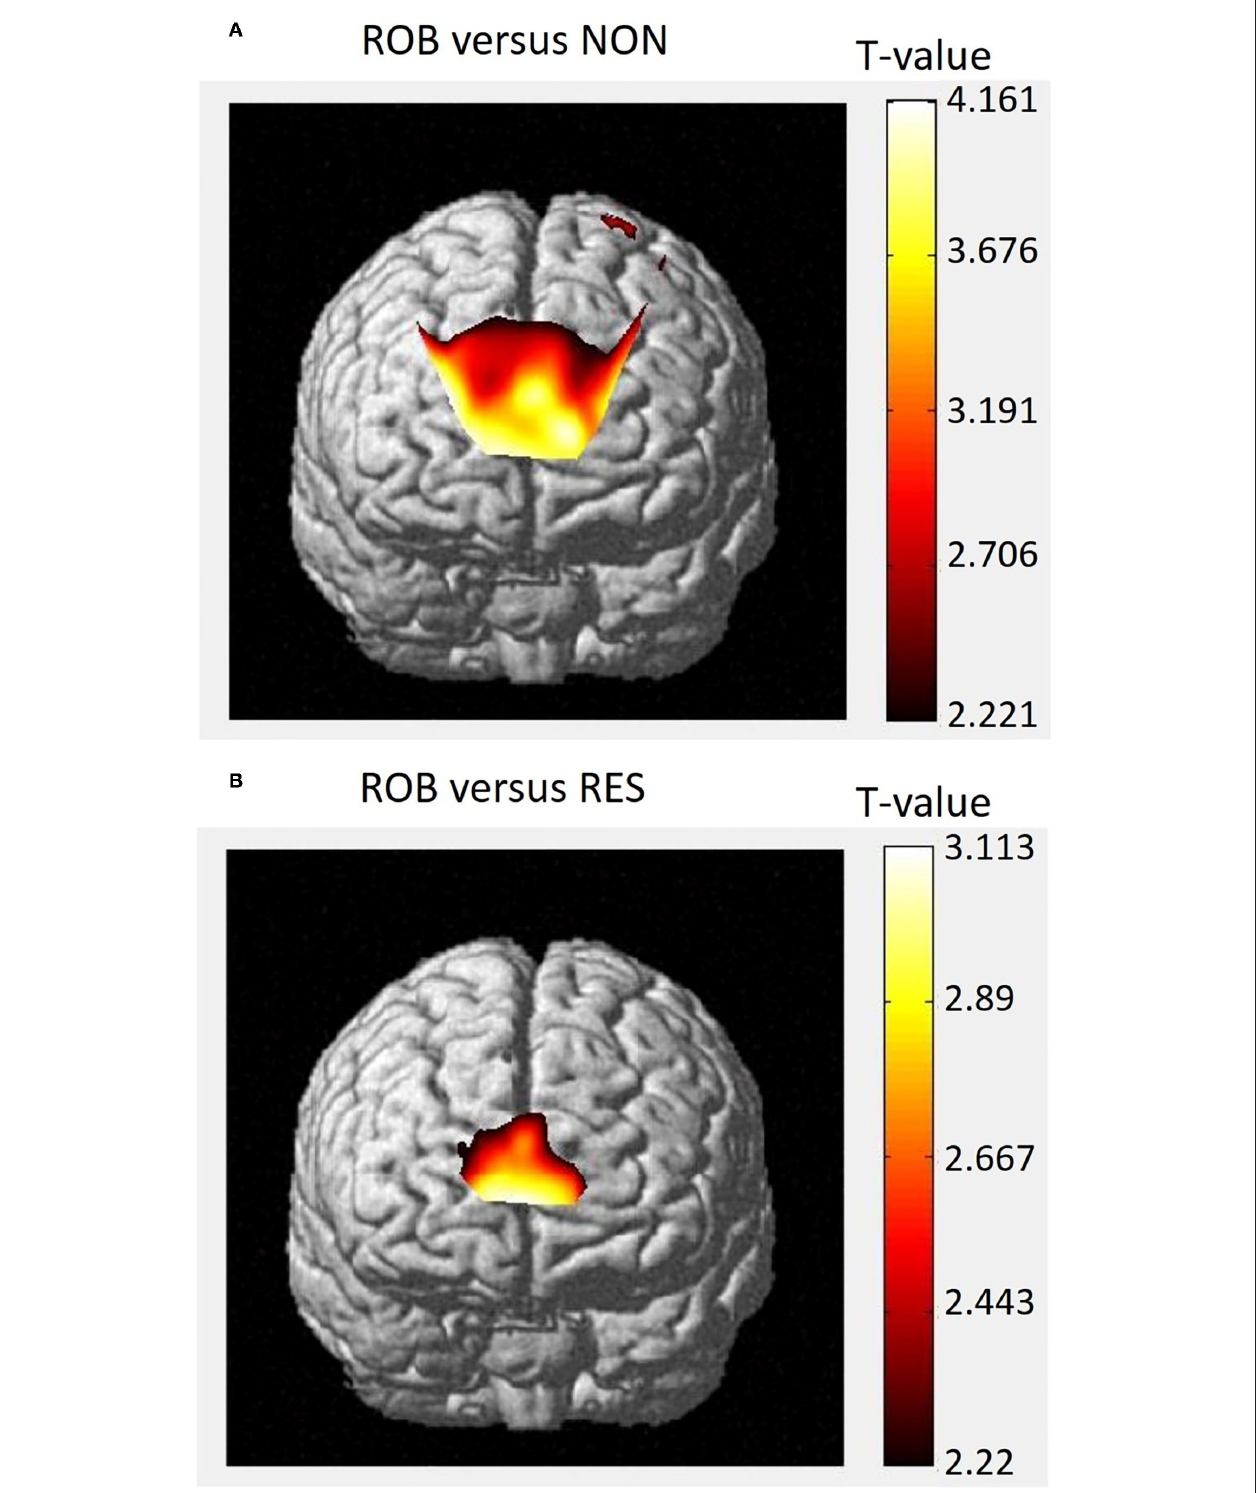
FIGURE 5 | Group-level t -statistic map. Execution-related cortical activations, as determined by NIRS-SPM, for the comparisons between (A) ROB vs. NON, and (B) ROB vs. RES. Higher t -values represent relatively higher levels of cortical activation.